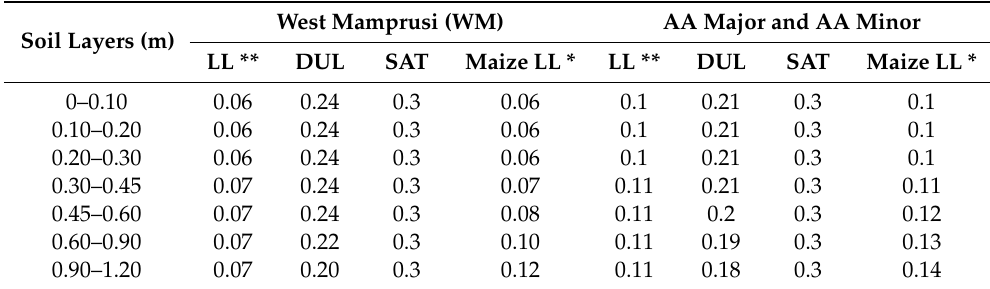
Table 5. Soil hydraulic properties used in Agricultural Production Systems Simulator (APSIM) for scenario simulations. West Mamprusi (WM) AA Major and AA Minor Soil Layers (m) LL ** DUL SAT Maize LL * LL ** DUL SAT Maize LL *